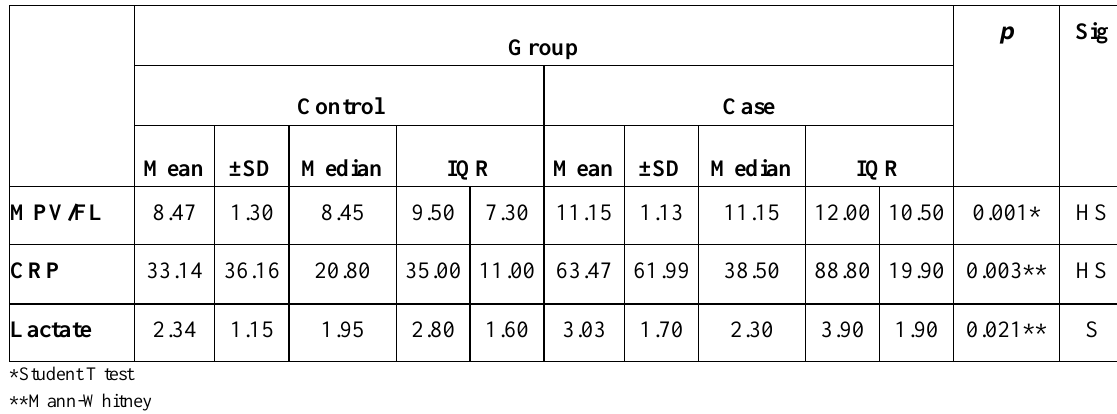
Table 2. Comparison between cases and controls as regard laboratory data.